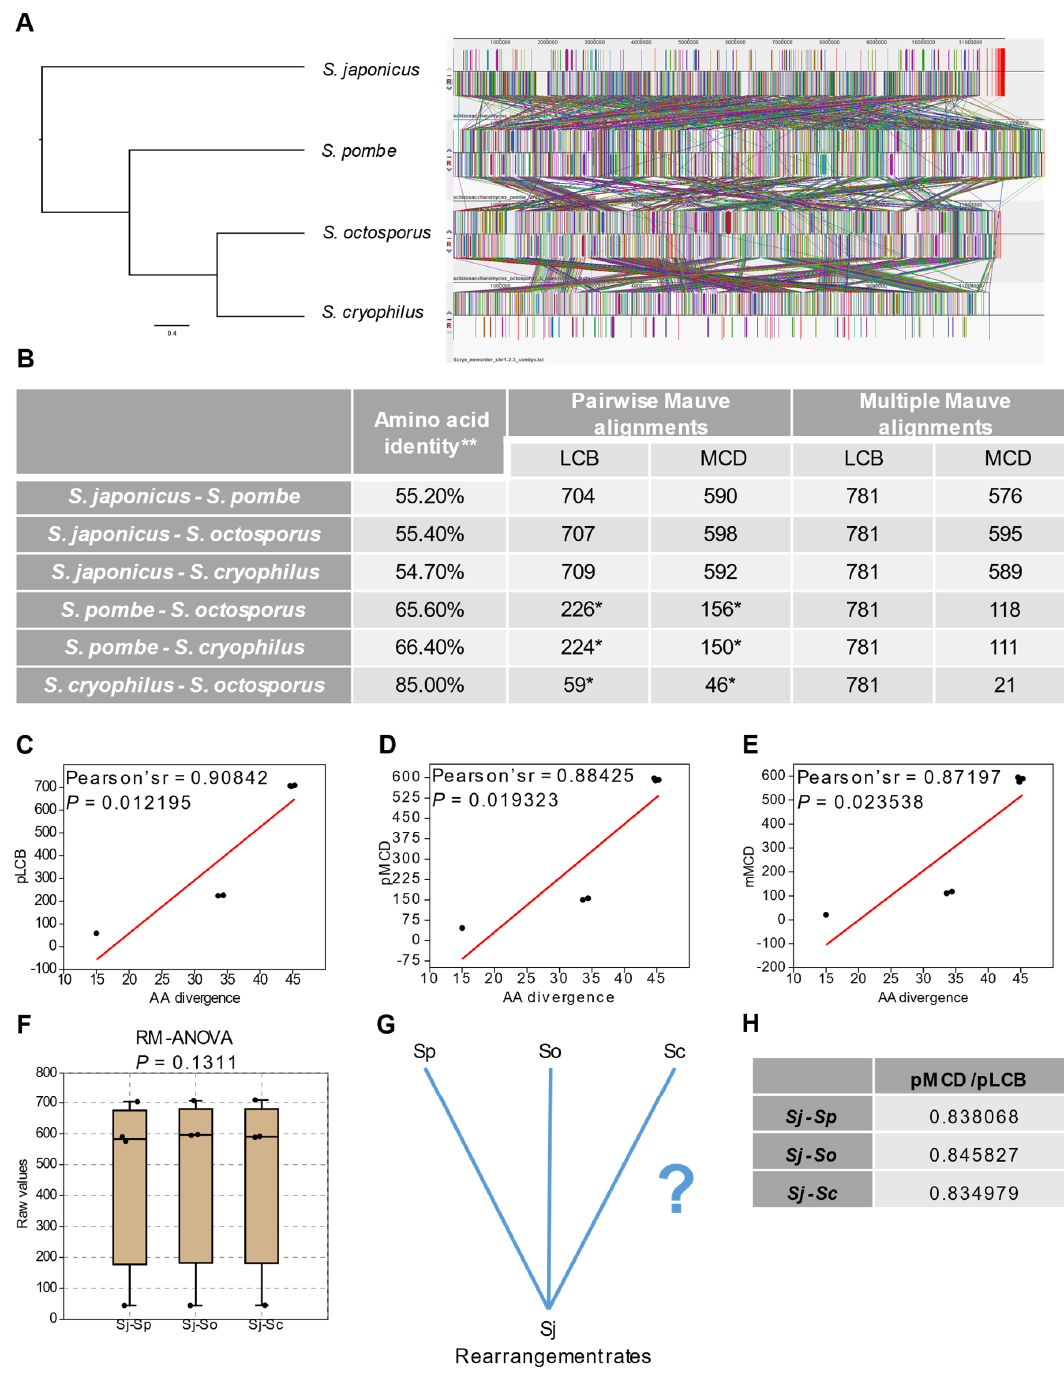
Figure 1. Sequence and structural evolution of the fission yeasts are correlated. ( A ) Whole genome alignments of the fission yeasts using S. japonicus as reference genome. Colourful rectangles and lines represent locally collinear blocks (LCBs) which are the most conserved collinear regions of the genomes. ( B ) Overall amino acid identity and the number of LCBs and corresponding multi-chromosomal distances (MCDs) in pairwise and multiple scenarios. * data are originated from [30]. ** data are established by [2]. ( C – E ) Correlations between amino acid differences (aa diff) and pairwise LCBs (pLCB), pairwise MCDs (pMCD), multiple MCDs (mMCD). Black dots represent the fission yeast species pairs, red lines are regression lines. The concerning values are correlated significantly in all pairwise comparisons. ( F ) Statistical evaluation of the aforementioned data in respect of the S. japonicus lineage. The data indicated that there were no significant discrepancies among the species pairs. ( G , H ) Rearrangement rates (pMCD/pLCB) suggested that the other fission yeasts species are almost equally distant from S. japonicus